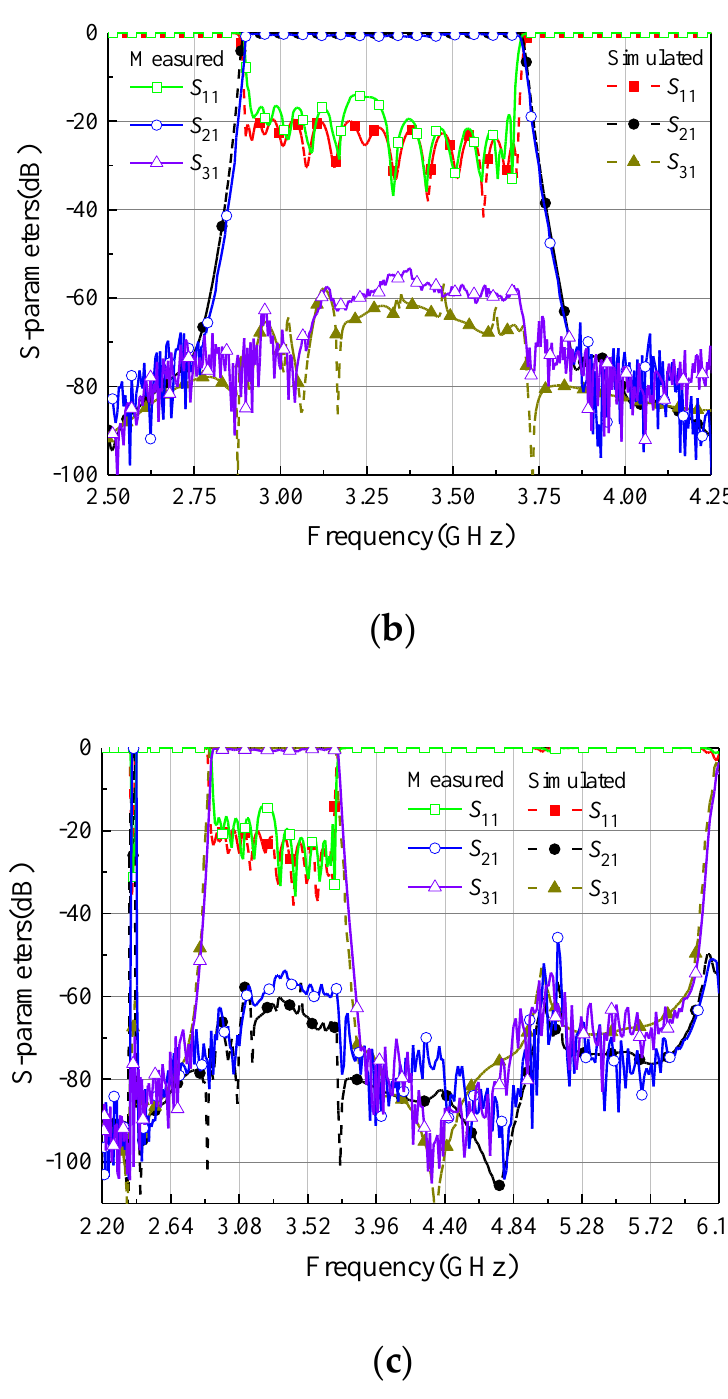
Figure 13. The measured and simulated frequency response of the HTS diplexer. ( a ) Channel I; ( b ) Channel II; ( c ) broadband. Table 4. Simulated and measured response of the diplexer.